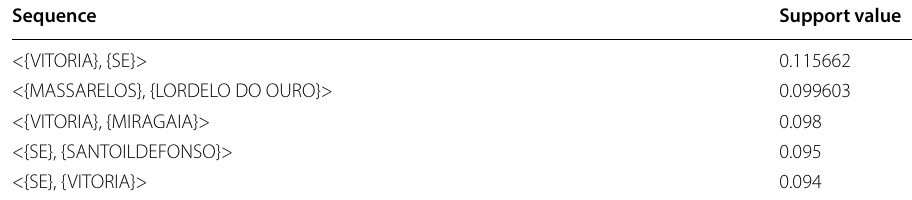
Table 6 Patterns generated by SPADE algorithm Sequence